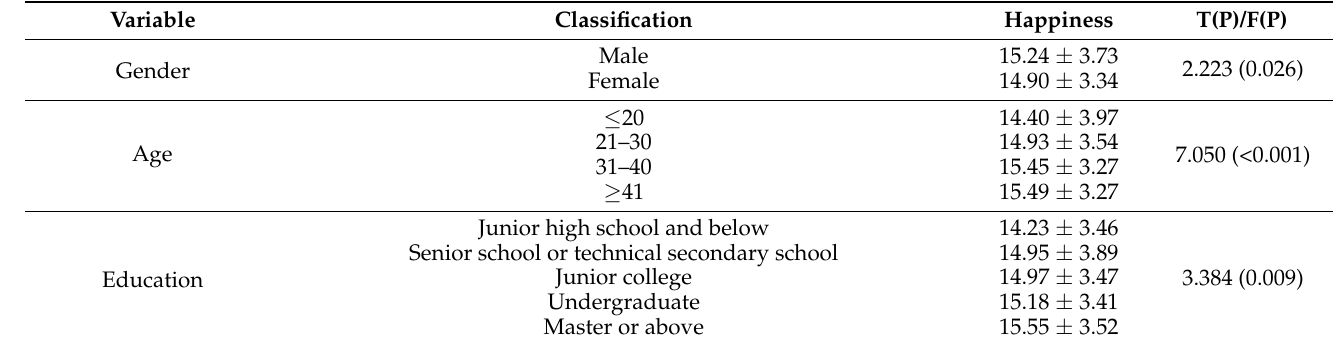
Table 3. The differences in happiness among urban young returnees in